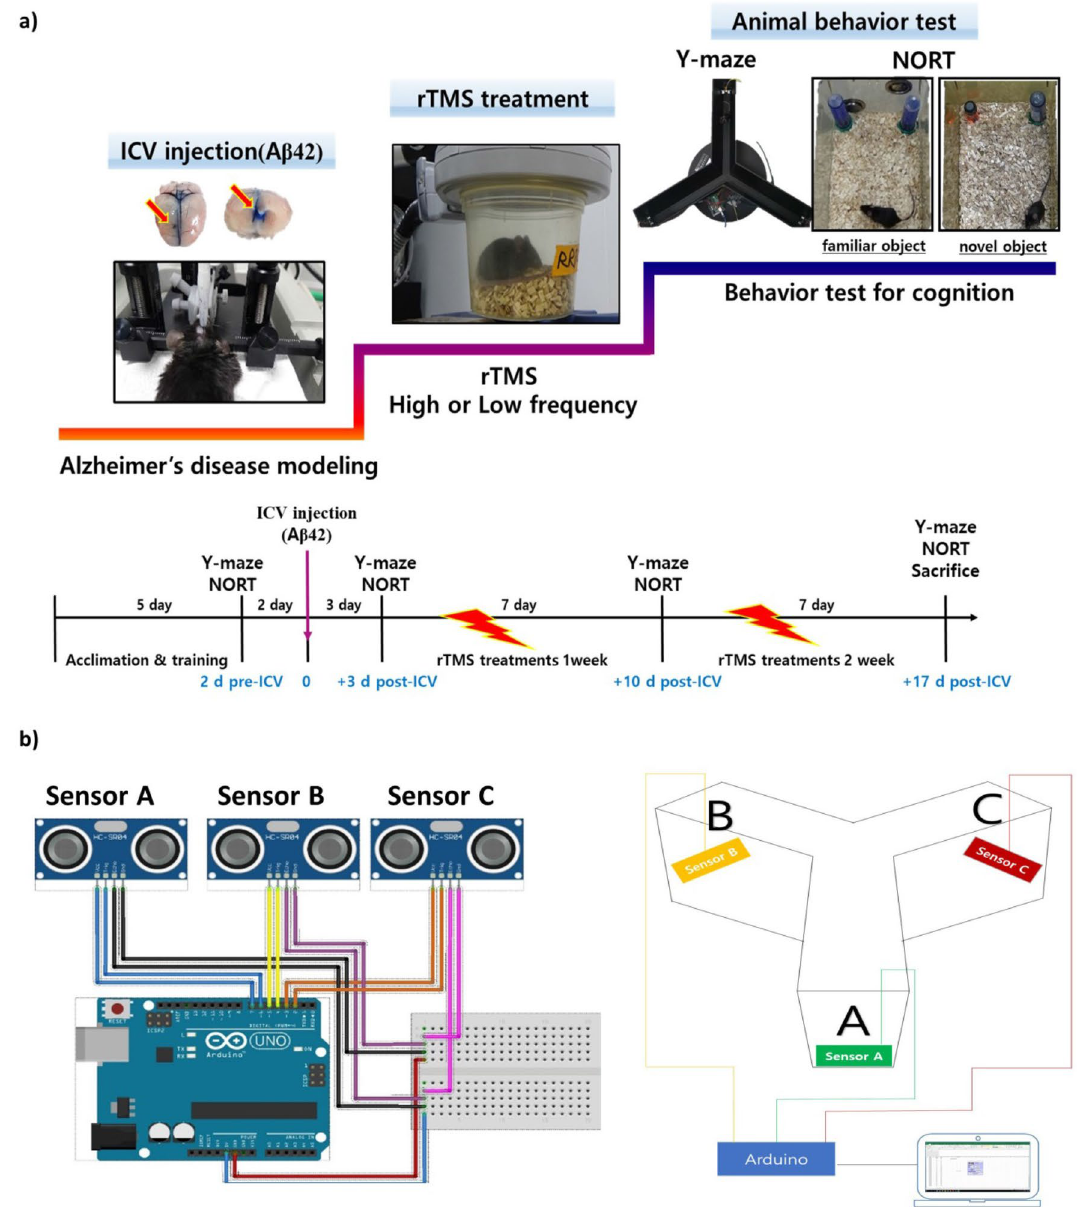
Figure 1. Experimental schematic and schedules. ( a ) The mice were administered Aβ42 oligomer via ICV using stereotaxic instrument with acceptable injection range (− 0.9 mm posterior, 1.7 mm right lateral, and 2.2 mm depth from bregma). Top view of the whole brain and coronal section show bilateral lateral ventricles filled with trypan blue. Two days before and three days after the Aβ42 injection, Y-maze test and NORT were performed to determine whether the Aβ42 induced Alzheimer’s disease status. After ICV administration, experimental groups were treated rTMS for 2 weeks while the control group did not receive rTMS. At the end of each week of intervention, Y-maze test and NORT were repeated. ( b ) Design and picture of an automatic Y-maze test system with an ARDUINO. Wiring diagram was drawn using FRITZING.ORG (developed by Friends-of-Fritzing, Germany) for the Arduino UNO microcontroller connected to three sonar sensors programmed to sensing either distance or location. Aβ42 amyloid beta 42 oligomer, ICV intracerebroventricular injection, NORT novel object recognition task, rTMS repetitive transcranial magnetic stimulation was selected because expressions of DR4, BDNF, nestin, and NeuN were increased in the brain of Hr-AD in vivo experiments while both of Hr-AD and Lr-AD groups showed therapeutic effects without differ- ences in the behaviour. As results, the concentration of dopamine was lower in the Aβ42 administered AD cells as compared to non-Aβ42 added control cells ( Ps < 0.05). The concentration of dopamine was higher in high- frequency rMS-treated cells than in those not rMS-treated in the AD model ( Ps < 0.05) (Fig. 5a). The mRNA levels of DR4 and BDNF were lower in Aβ42-administered cells than in all non-Aβ42 administered cells: control,